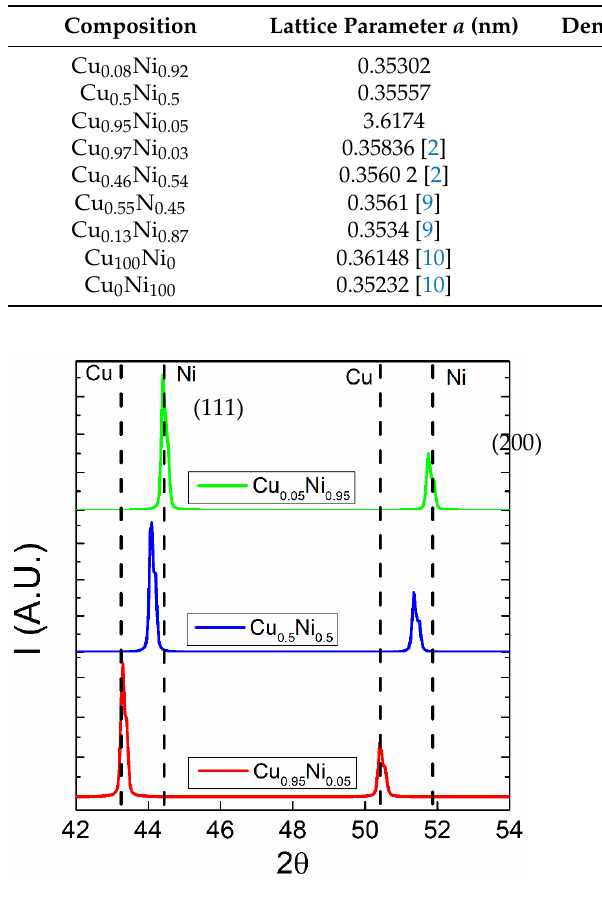
Figure 1. Primitive cell of Cu–Ni; the blue atom corresponds to Cu and Ni; the contents of atom are Cu 0 . 5 Ni 0 . 5 , Ni 0 . 92 Cu 0 . 08 , and Cu 0 . 95 Ni 0 . 05 . Red line and point refer to integration path and k ‐ point in Brillouin zone. g (cid:4652)⃗ 1 , g (cid:4652)⃗ 2 , g (cid:4652)⃗ 3 are reciprocal vector. Table 1. Optimized lattice parameter for Cu–Ni alloys with experiments [2,9,10].